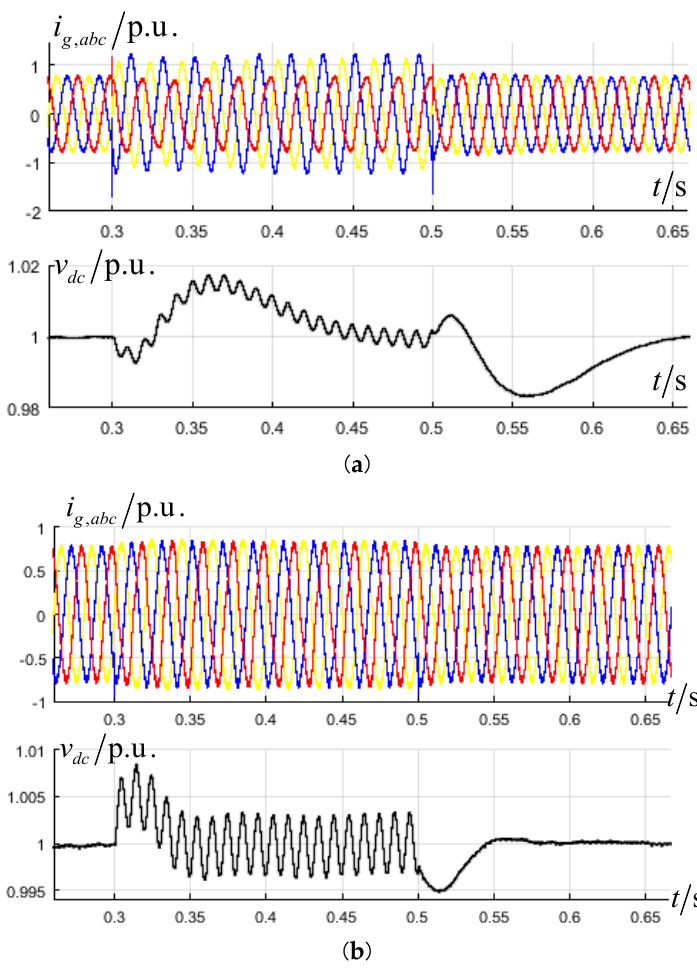
Figure 12. The critical simulation waveforms under the asymmetric voltage drop: ( a ) without negative voltage feed forward; ( b ) with negative voltage feed forward.